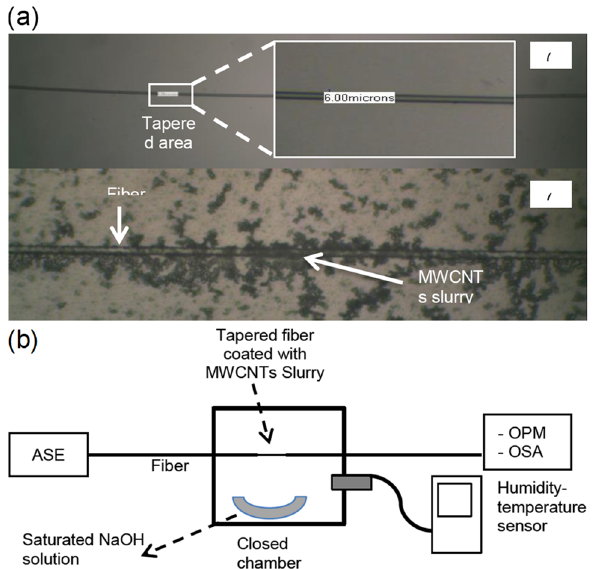
Figure 25. Point sensor. ( a ) Top: bare tapered fiber. ( b ) Droplet of MWCNTs-acetone on the tapered optical fiber. ( b ) Experimental setup. Adapted with permission from ref. [121]. Copyright 2017 IASE